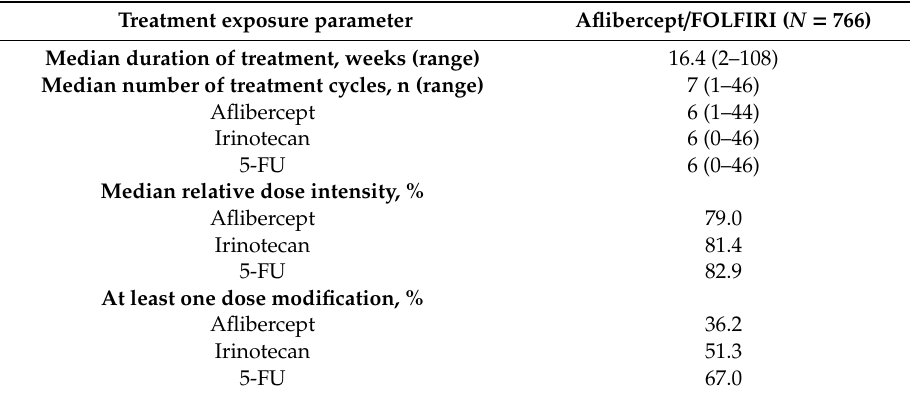
Table 2. OZONE study treatment